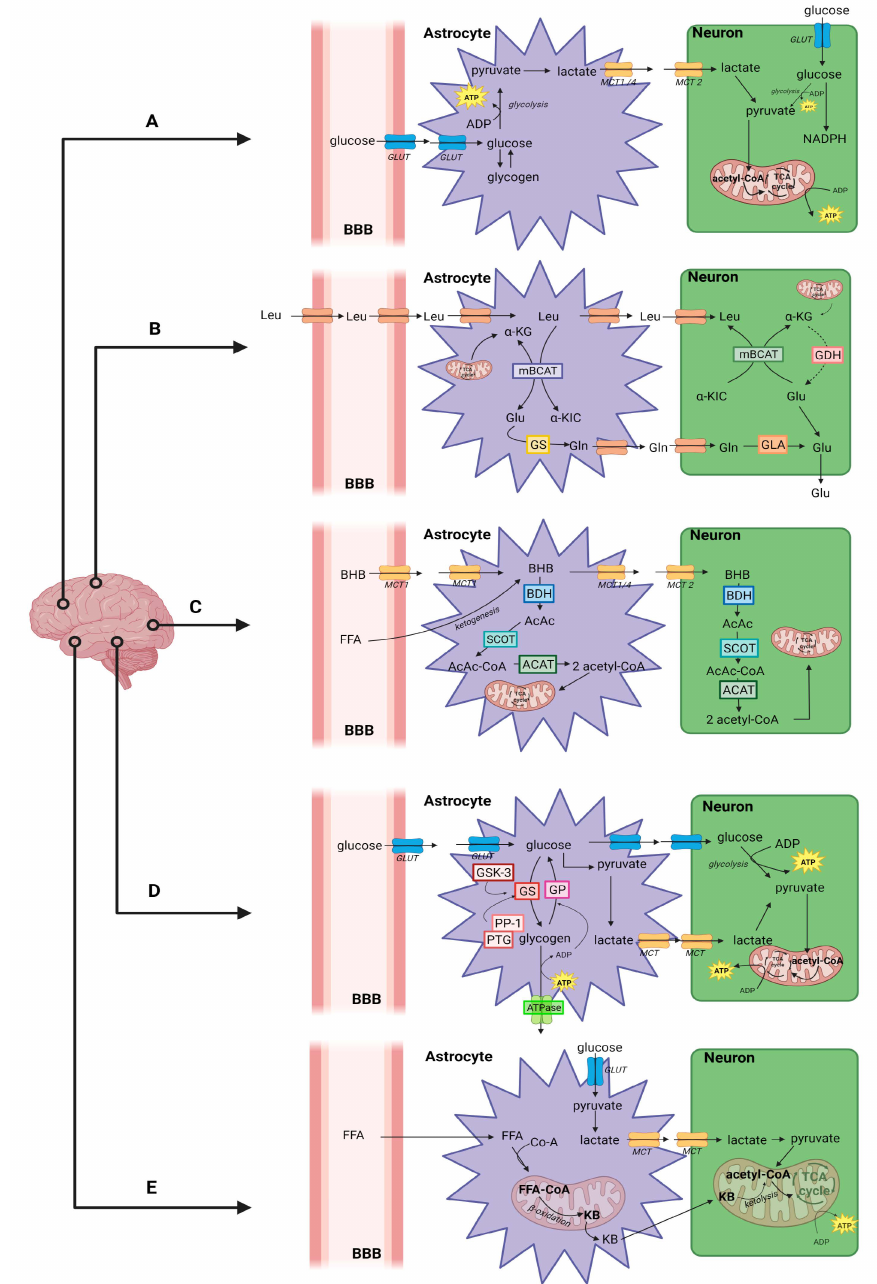
Figure 1. Brain energy metabolism: A—Glucose and lactate metabolism: Via the glucose trans- porter (GLUT), glucose crosses the blood–brain barrier (BBB) and is taken up by astrocytes. In the astrocyte, glucose can be stored as glycogen or metabolized by glycolysis. Pyruvate (a product of glucolysis) is converted by lactate dehydrogenase (LDH) to lactate, which is then transported by monocarboxylate transporters (MCT)1,2 and 4 from astrocytes to neurons. In the neurons, lactate is converted back by LDH into pyruvate, which is transferred to the mitochondria for aerobic energy production via the tricarboxylic acid (TCA) cycle. Glucose, which is directly taken up by neurons, can be used as an energy source in glycolysis or is transported to the pentose–phosphate pathway (PPP) for NADPH production [43]. B—Metabolism of branched-chain amino acids: Leucine